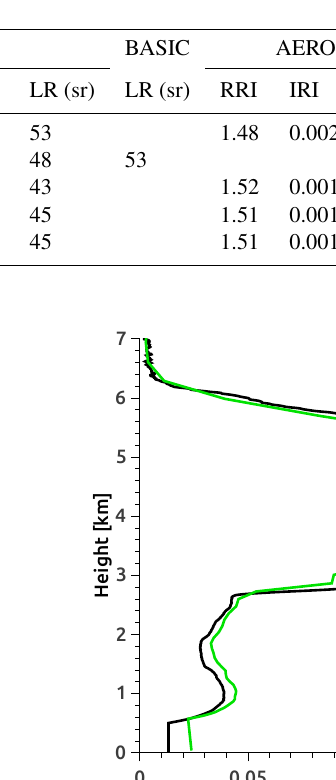
Table 1. Aerosol properties retrieved by GARRLiC, BASIC, and AERONET. The LR values marked by ** were linearly interpolated to lidar wavelength. The abbreviations f, c, and t correspond to fine, coarse, and total aerosol modes, respectively (AOD 440nm ≈ 0 . 52; α ≈ 0 . 27 for 440/870nm).